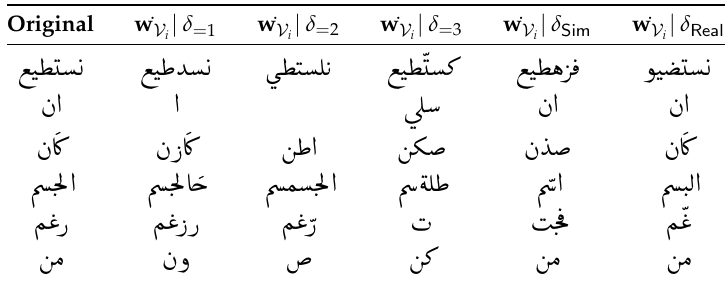
Table 5. Examples of Word